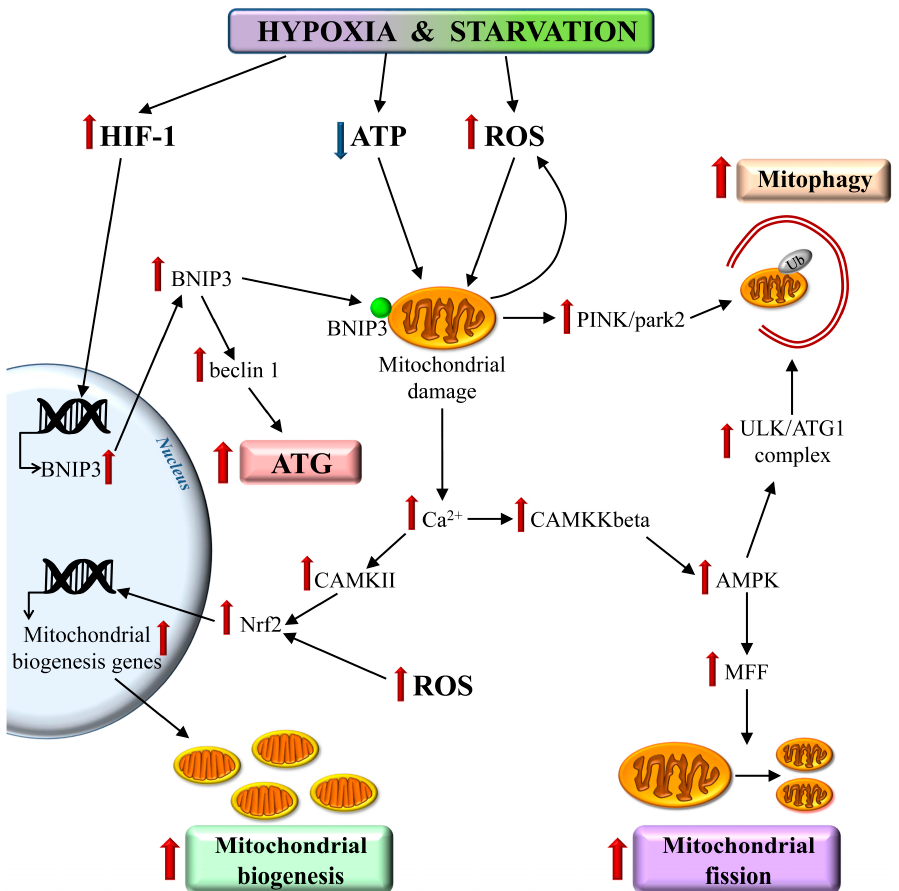
Figure 3. CBH induces mitophagy. Hypoxia heavily affects the mitochondria by interfering with the mitochondrial respiratory chain, and by dramatically decreasing the mitochondrial ATP production.